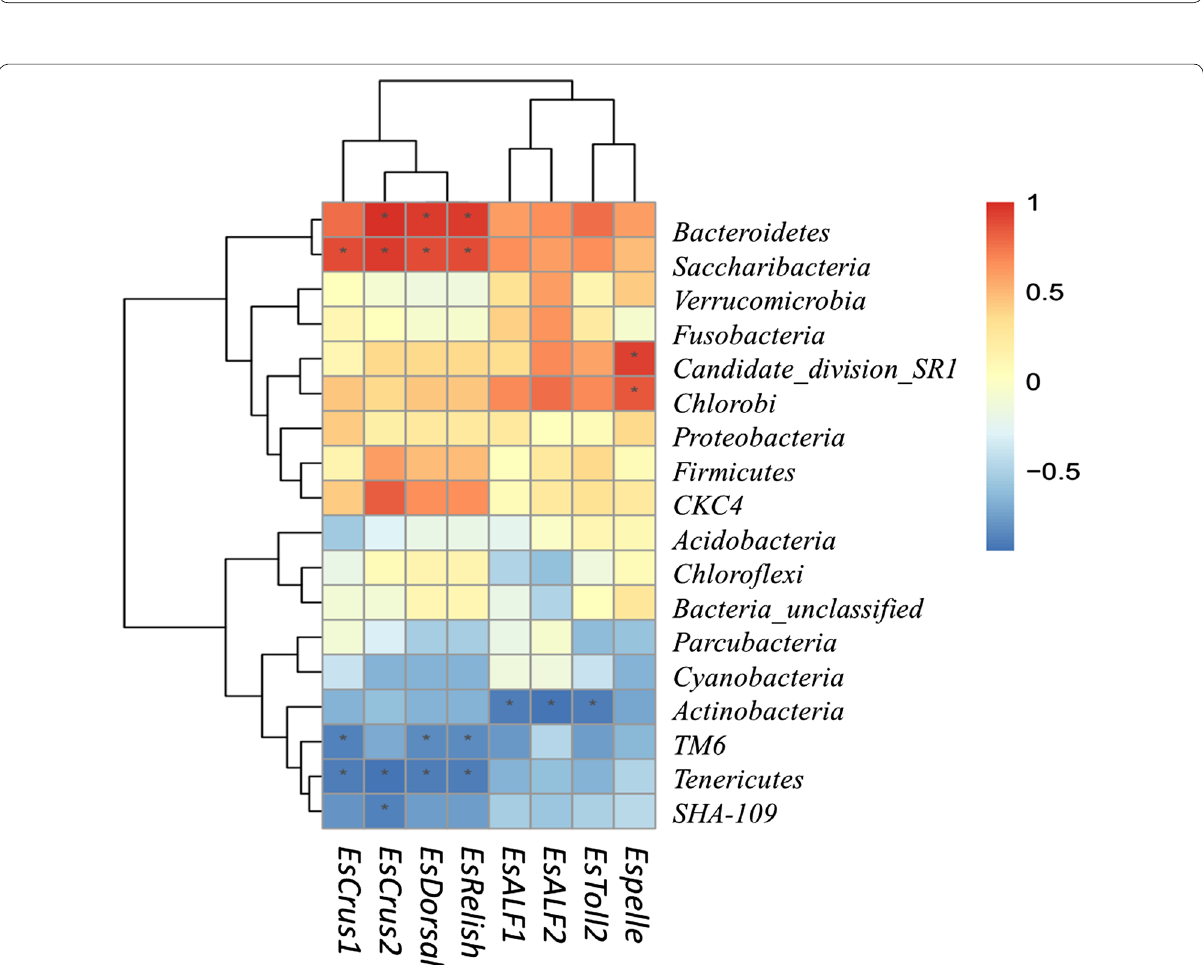
Fig. 5 Comparative analysis on eight gut immune genes expression (relative to Es - β - Actin ) in the same regions of the E. sinensis intestinal tract (mean SEM, n 3). a Midgut, b hindgut. Different letters indicate significant differences ( P < 0.05) ± =